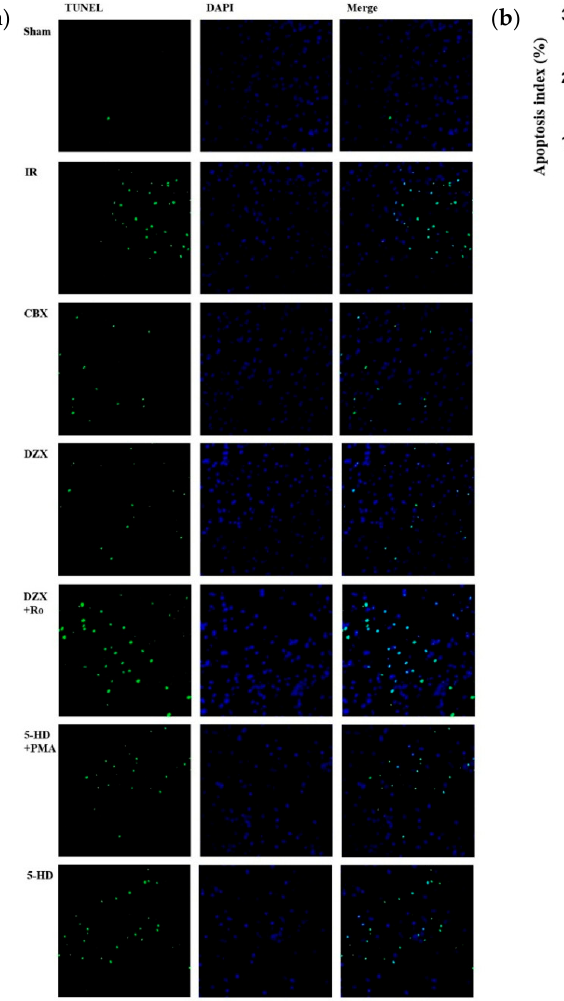
Figure 4. Effect of the mitoKATP channel and protein kinase C on cell apoptosis. ( a ) Representative images of cell apoptosis by TUNEL staining; ( b ) Apoptosic index in different groups. Data are presented as mean ± standard deviation, n = 3 in each group. F = 975.8, p ≤ 0.05; a p ≤ 0.01 vs. Sham; b p ≤ 0.01 vs. IR; c p ≤ 0.05 vs. DZX; d p ≤ 0.05 vs. 5-HD. 5-HD: 5-hydroxydecanoic acid; CBX: carbenoxolone; DAPI: 4 ′ ,6-diamidino-2-phenylindole; DZX: diazoxide; IR: ischemia-reperfusion; PMA: phorbol-12-myristate-13-acetate; Ro: Ro-31-8425; TUNEL: transferase dUTP nick end labeling.